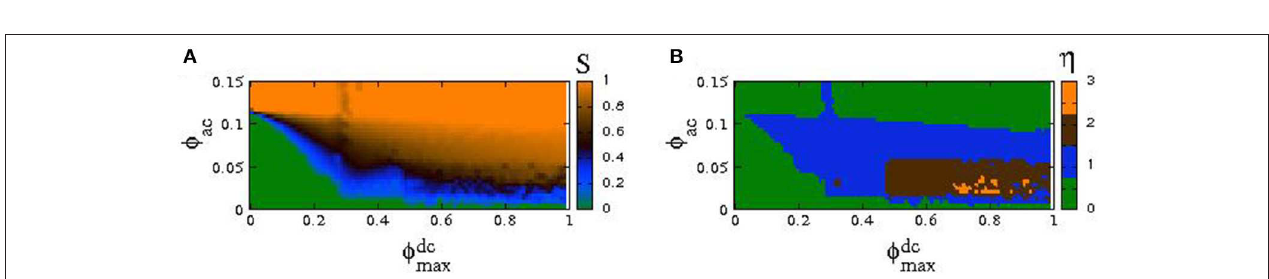
FIGURE 12 | The magnitude of the synchronization parameter averaged over the steady-state integration time and the maximum dc flux bias ( φ ac